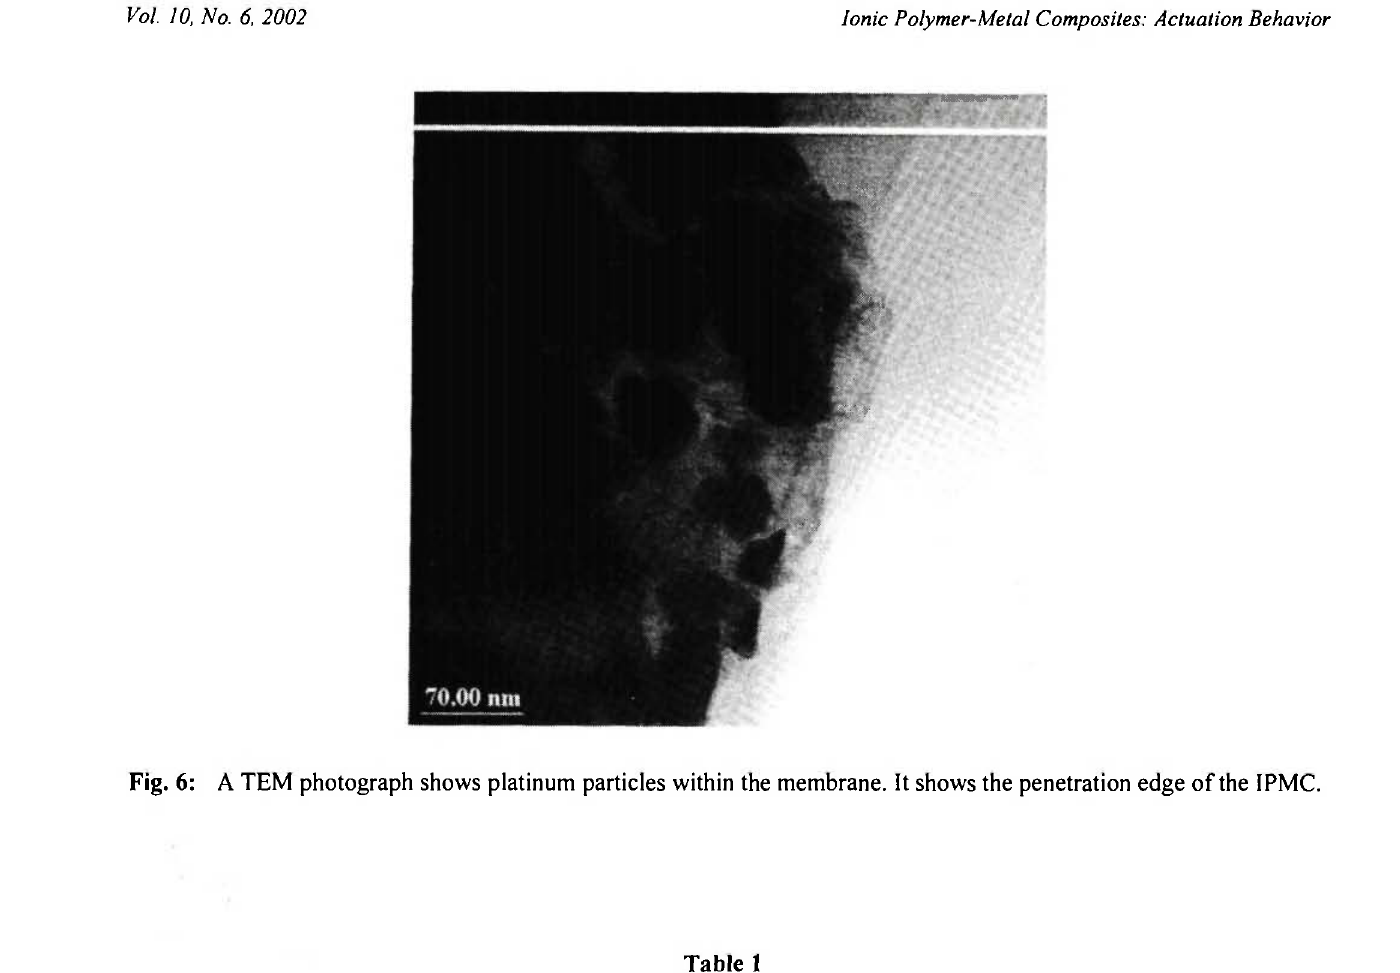
Fig. 6: A TEM photograph shows platinum particles within the membrane. It shows the penetration edge of the